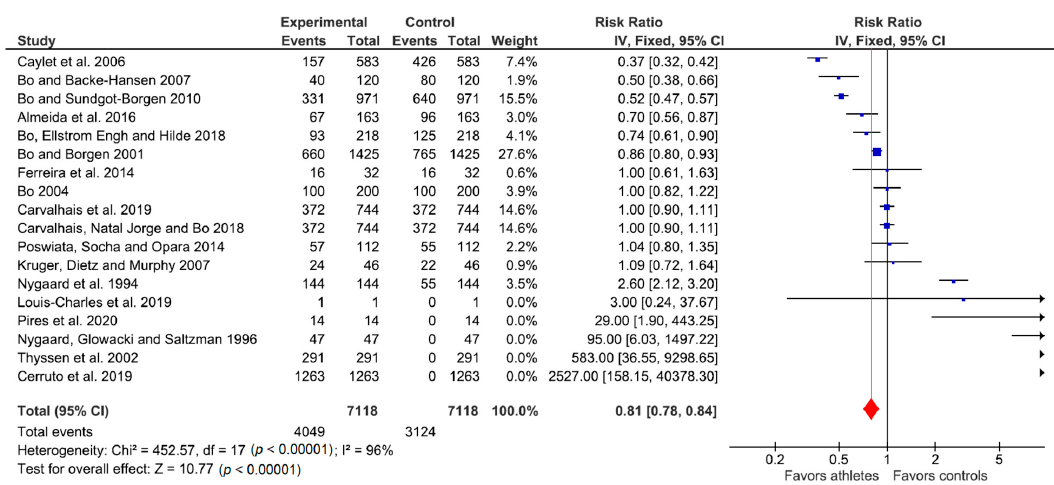
Figure 2. Meta-analysis of studies on the effect of physiotherapy as a treatment for urinary incontinence in female athletes when compared to female controls.